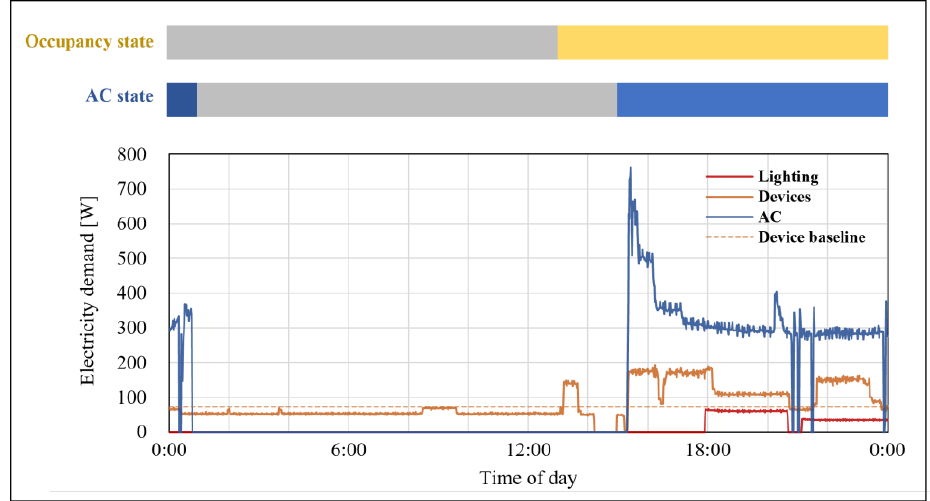
Figure 3. Example of detected daily occupancy and cooling usage patterns for one household.